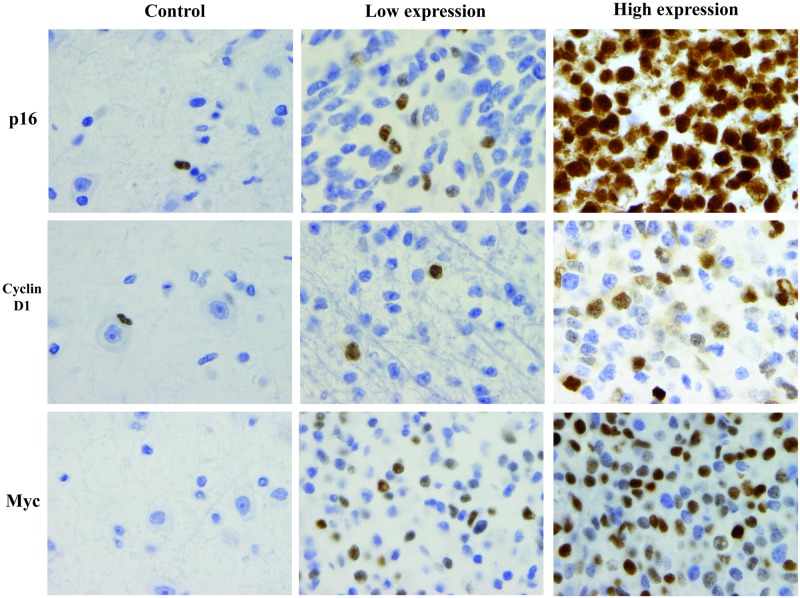
Representative low and high nuclear immunostaining for p16, Cyclin D1 and Myc and their normal brain control.For p16 and Cyclin D1 rare astrocytes are positive in normal cortex whereas no staining is observed for Myc (magnification x 1000 for all pictures).